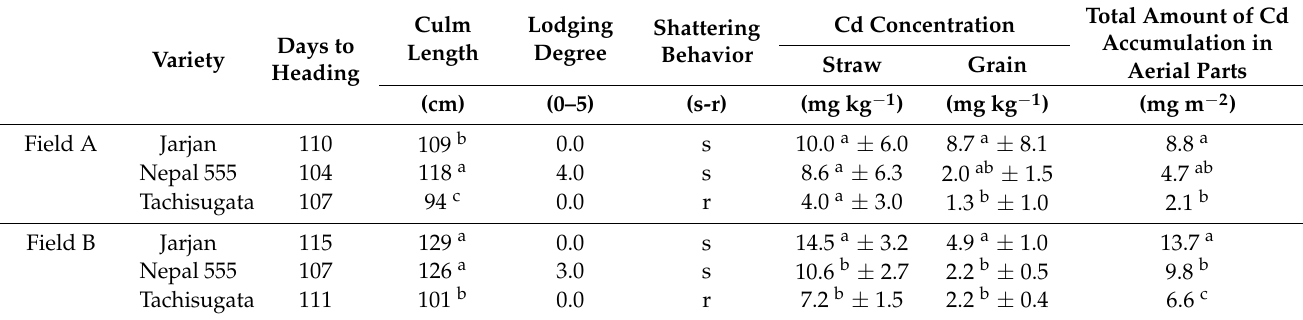
Table 1. Agronomic traits and Cd accumulation ability of parental varieties grown under early drainage water management in two farmers’